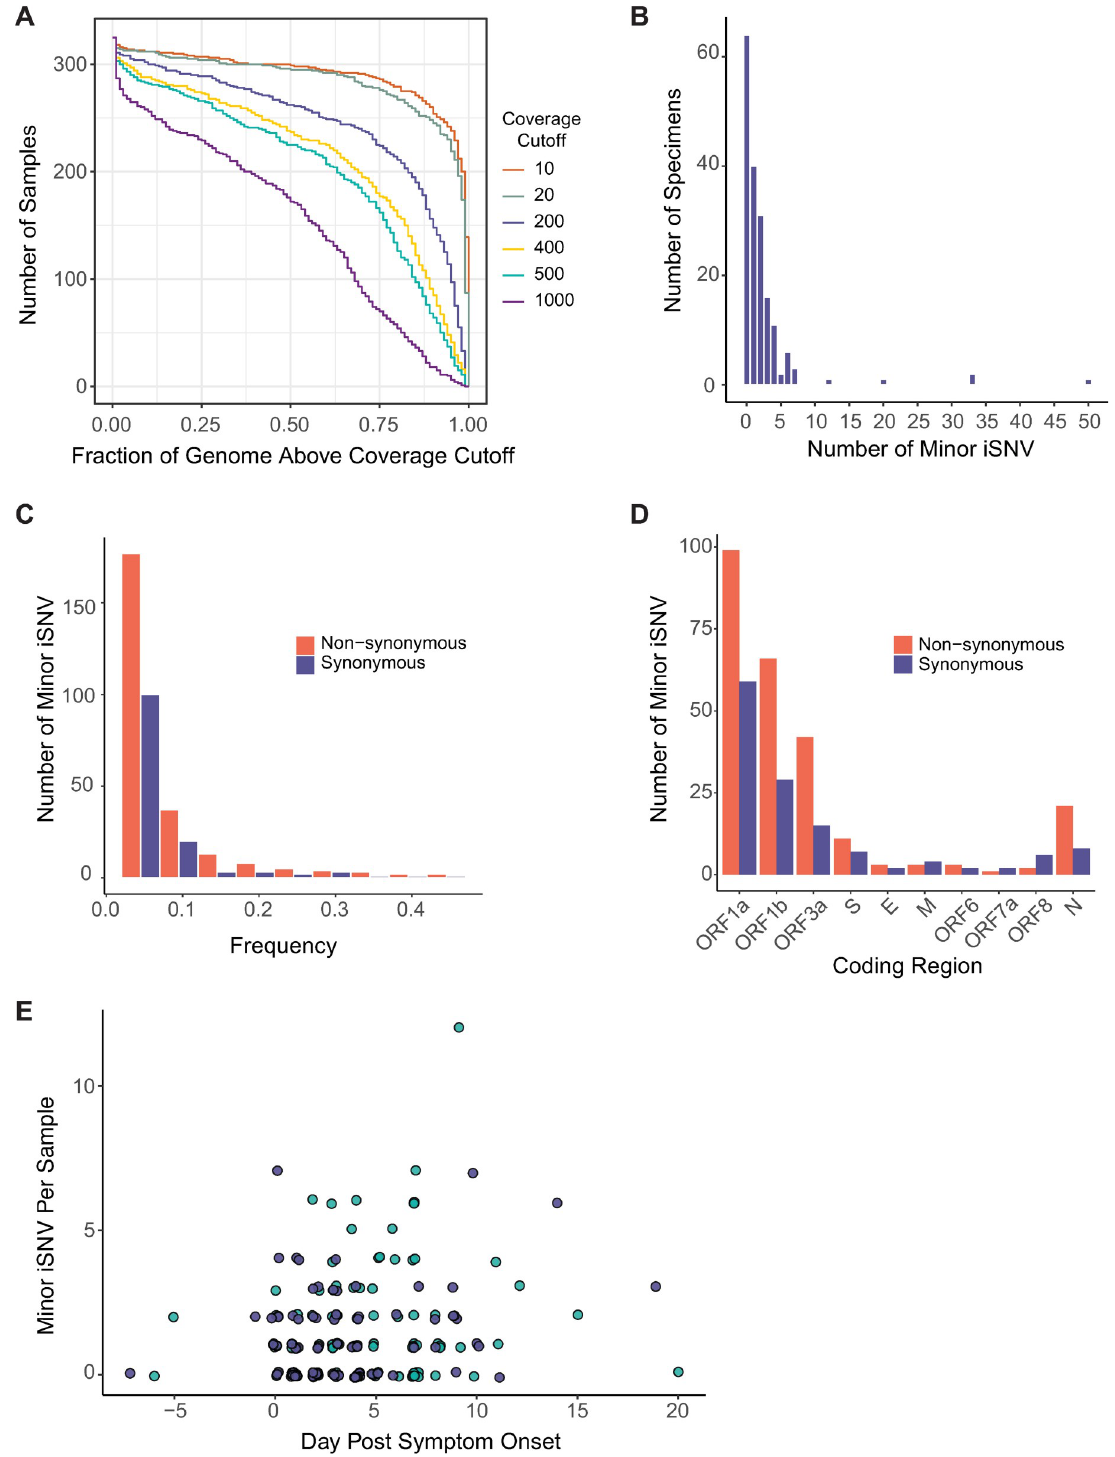
Fig 3. SARS-CoV-2 intrahost single nucleotide variant (iSNV) diversity. (A) Sequencing coverage for clinical samples. The number of clinical samples (y-axis) is shown by the fraction of the genome above a given read depth threshold (x-axis). The different lines show the data evaluated with six read depth thresholds. (B) Histogram of the number of specimens (y-axis) by the number of minor iSNV per sample (x-axis), n = 178. (C) Number of minor iSNV by frequency with a bin width of 0.05. Non-synonymous iSNV are shown in orange and synonymous iSNV are shown in violet. (D) Number of minor iSNV by coding region. Non-synonymous iSNV are shown in orange